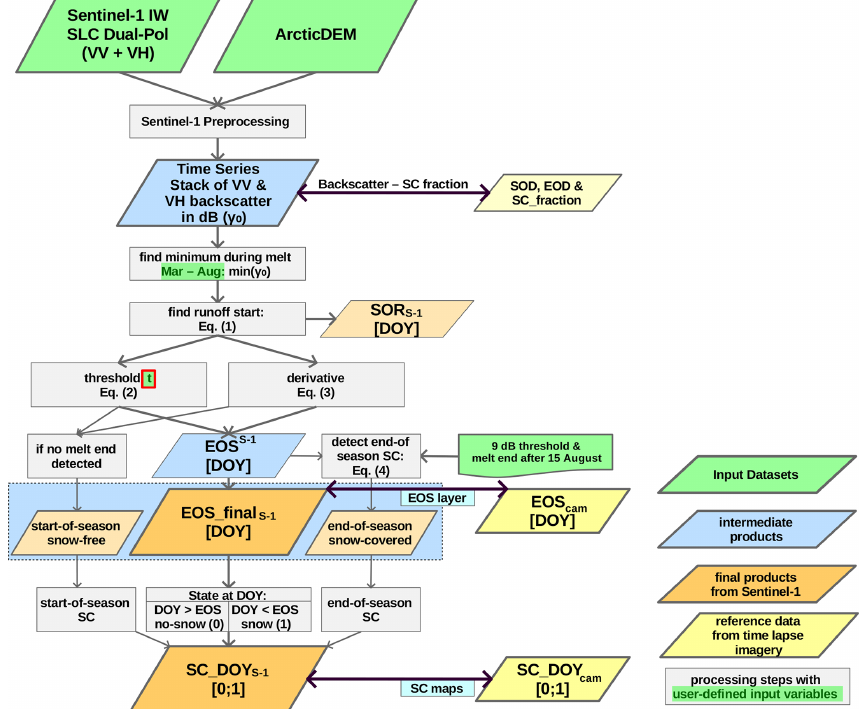
Figure 4. Workflow chart of proposed approach to detect (i) snow cover (SC) and timing of snowmelt as (ii) start of runoff (SOR) and (iii) end of snow cover (EOS) from Sentinel-1. EOS (iv) start-of-season snow-free and (v) end-of-season snow-covered areas are visualized together as the so-called melt layer (Figs. 11 and 12), whereas analysis is conducted